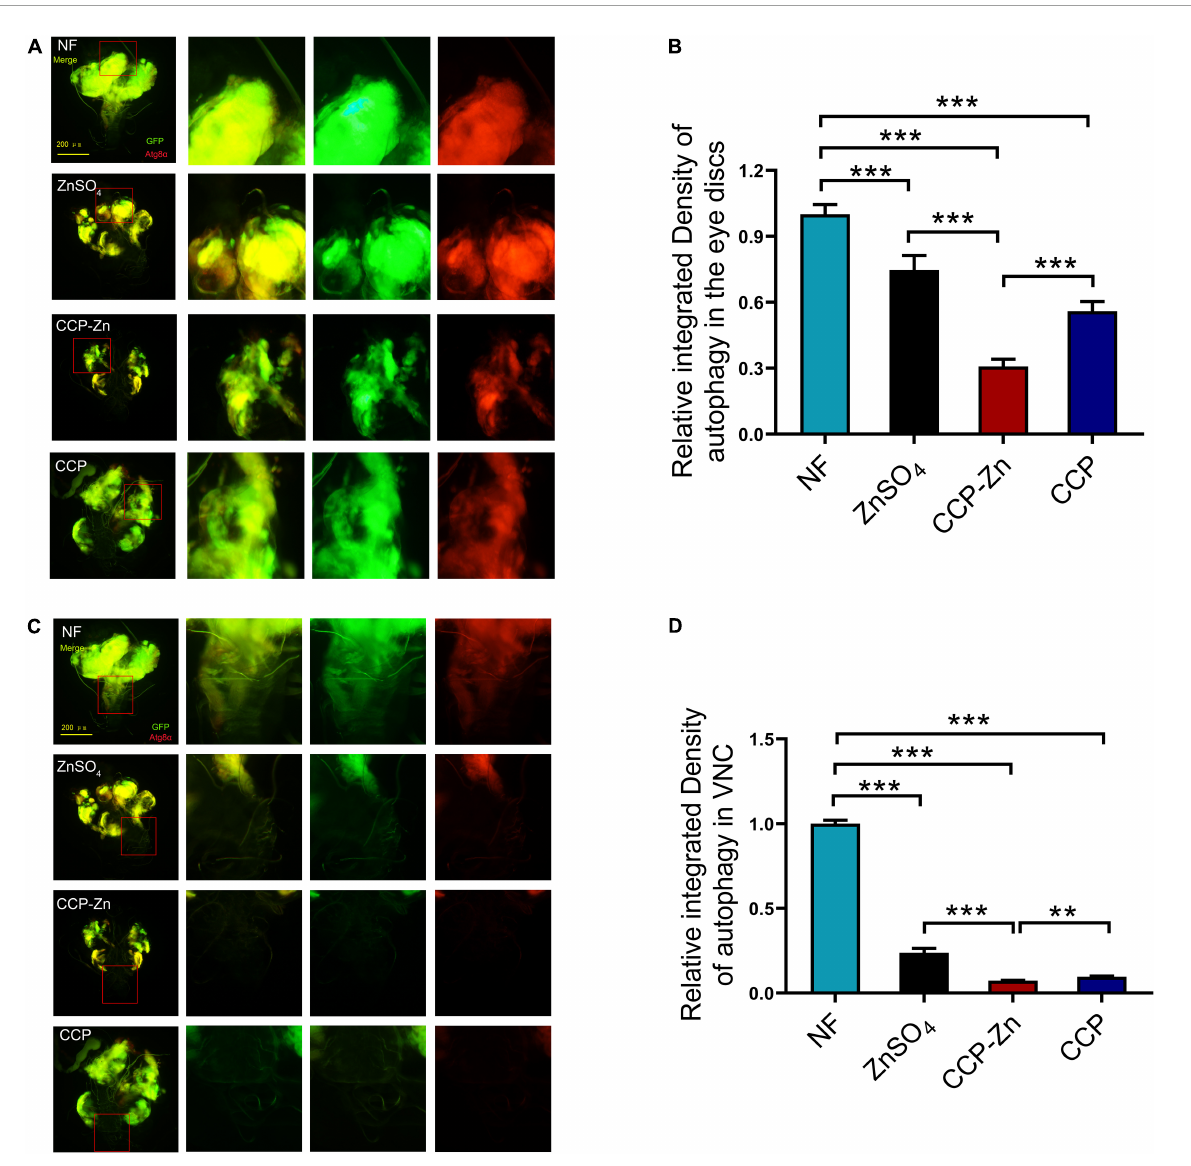
FIGURE6 ZnSO 4 , CCP, or CCP–Zn inhibit tumor growth, invasion, and migration by suppressing autophagy in Drosophila . (A) ZnSO 4 , CCP, or CCP–Zn inhibits autonomous and non-autonomous autophagy in the eye discs of tumor Drosophila . (B) Quantification of tumor size and fluorescence intensity of (A) . (C) Activation of autophagy in VNC of tumor Drosophila at day 12 AEL can be rescued when they reared on ZnSO 4 , CCP, or CCP–Zn media. (D) Quantification of fluorescence intensity of (C) . Data are represented as mean ± SEM of the biological replicates. ** p < 0.01, *** p < 0.001; two-tailed Student’s t